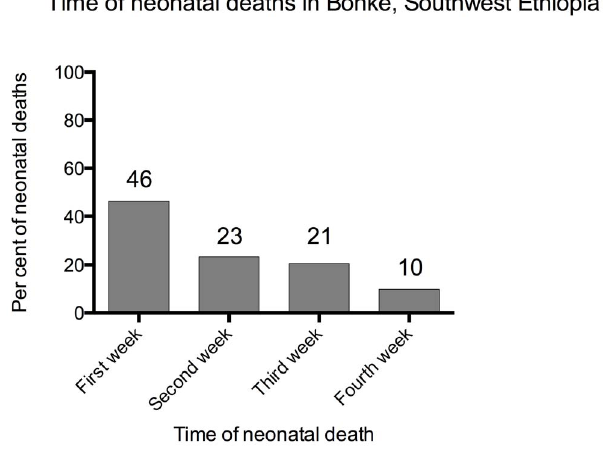
Figure 1. Time of maternal deaths, Bonke woreda, south-west Ethiopia, 2010.